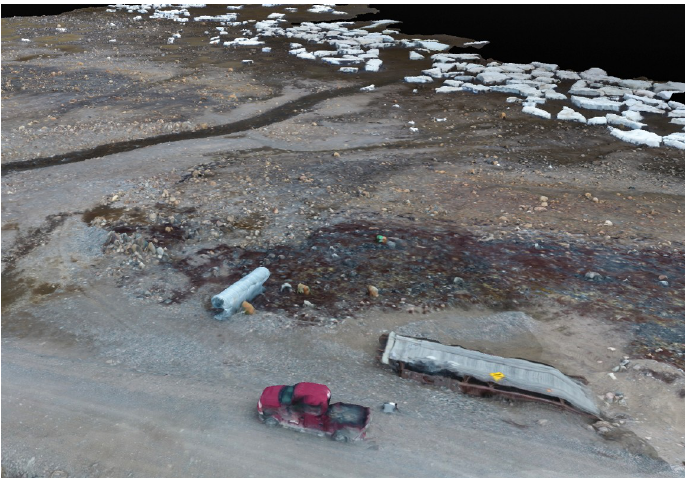
Fig 6. Three-dimensional rendering. This photo captures the power of the three-dimensional meshing produced using UAV images taken at approximately 75’ above ground level. Three-dimension meshing, processed by Pixel3D, produced near-real life textures that could be beneficial in hazard mapping and emergency preparedness. Photo generated by Dylan G. Clark, with approval to distribute under the CC BY license.